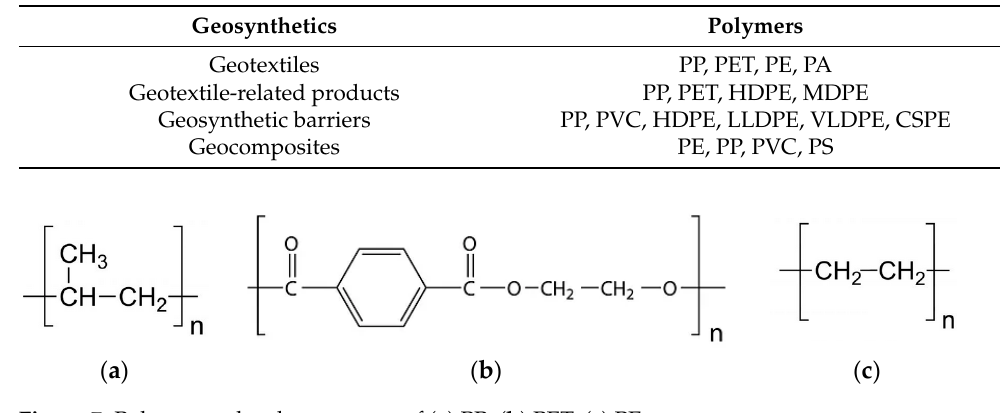
Figure 7. Polymer molecular structure of ( a ) PP; ( b ) PET; ( c ) PE.